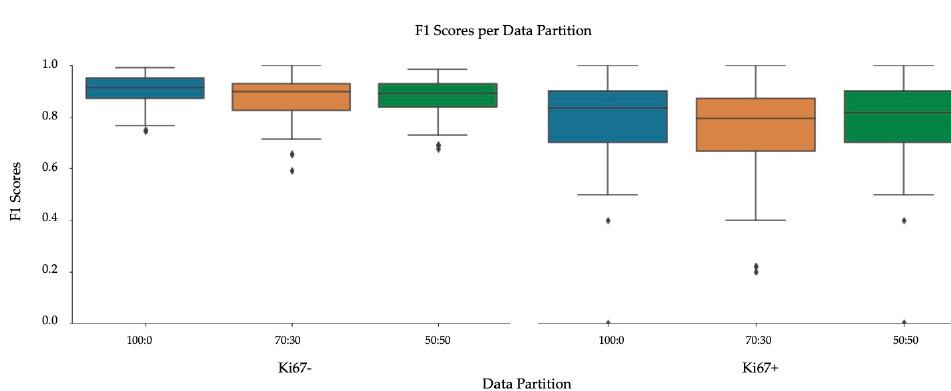
Figure 12. F1 Scores on SMH patches, per stain (Ki67 − and Ki67+), comparing data